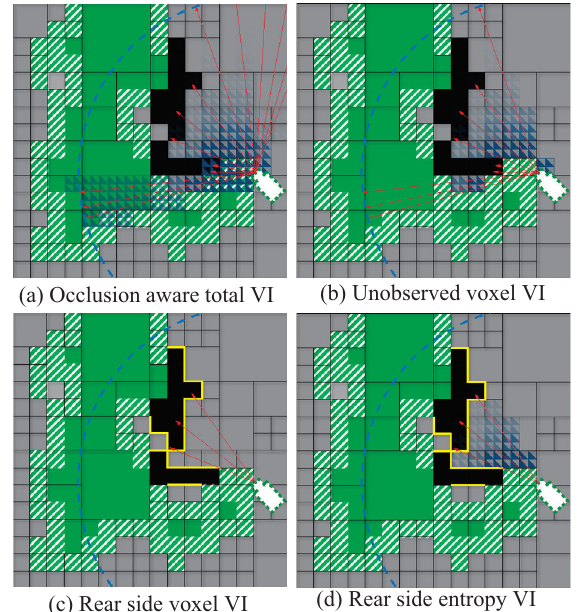
Fig. 9 Four VI formulations. Voxels colours are: black: occupied, grey: unknown, green: free, striped: frontier. Other markings are: yellow lines: object sides, red arrows: ray sets, dashed blue circle: maximal ray length blue triangles: VI weights. Proximity count VI behaves like rear side voxel VI (bottom left), but with a weight dependent on distance from previously observed surface voxels. Reproduced with permission from Ref. [25], c (cid:2) Springer Nature